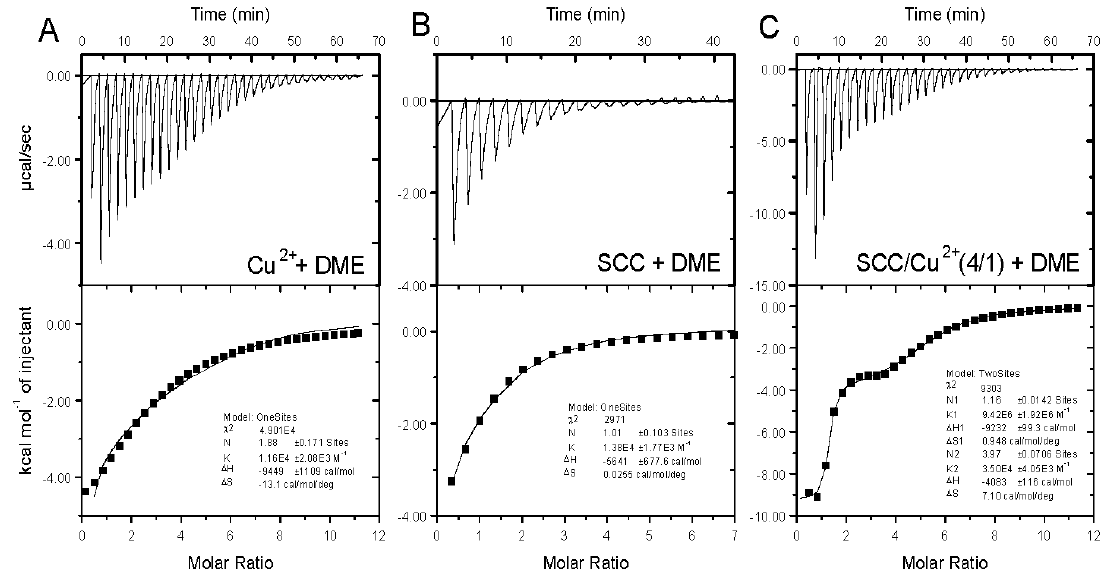
Figure3. BindingisothermsforcomplexationofCu 2 + , SCC,andSCC / Cu 2 + withDMEat25 ◦ C.Titrations Figure 3. Binding isotherms for complexation of Cu 2+ , SCC, and SCC/Cu 2+ with DME at 25 °C. of ( A ) 84.3 µ M Cu(ClO 4 ) 2 with 5.0 mM DME, ( B ) 84.3 µ M SCC with 5.0 mM DME, and ( C ) 84.3 µ M Titrations of ( A ) 84.3 μM Cu(ClO 4 ) 2 with 5.0 mM DME, ( B ) 84.3 μM SCC with 5.0 mM DME, and ( C ) SCC / Cu 2 + (4 / 1) with 5.0 mM DME in H 2 O at 25 ◦ C were performed using an ITC microcalorimeter. 84.3 μM SCC/Cu 2+ (4/1) with 5.0 mM DME in H 2 O at 25 °C were performed using an ITC microcalorimeter. Table 2. Thermodynamic parameter for complexation of Cu 2 + , SCC, and SCC / Cu 2 + with DME at 25 ◦ C. Table 2. Thermodynamic parameter for complexation of Cu 2+ , SCC, and SCC/Cu 2+ with DME at 25 °C.